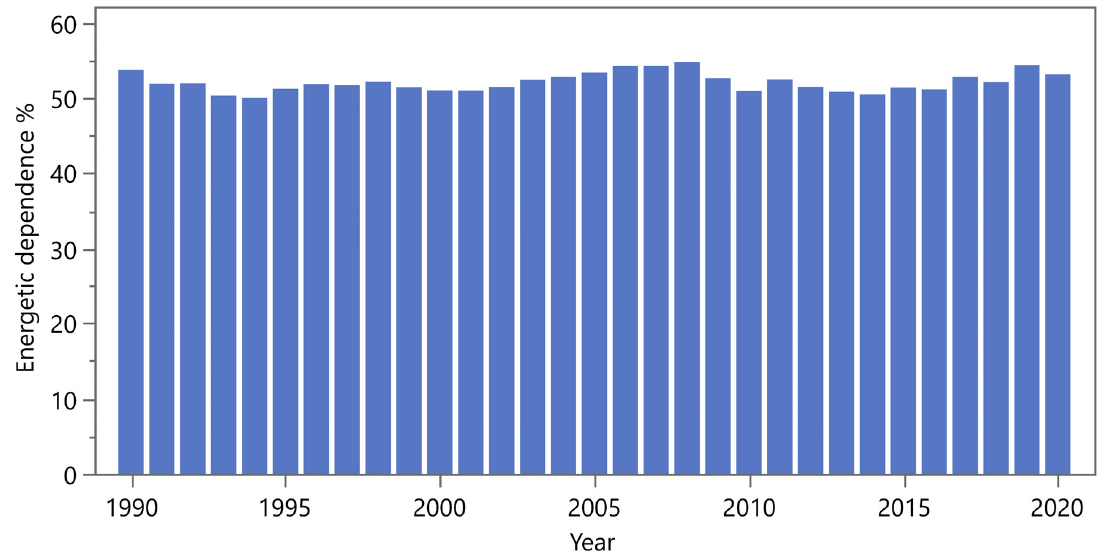
Figure 8. Average values of energy dependence in EU in 1990–2020. Source: own processing according to [20], processing in JMP.